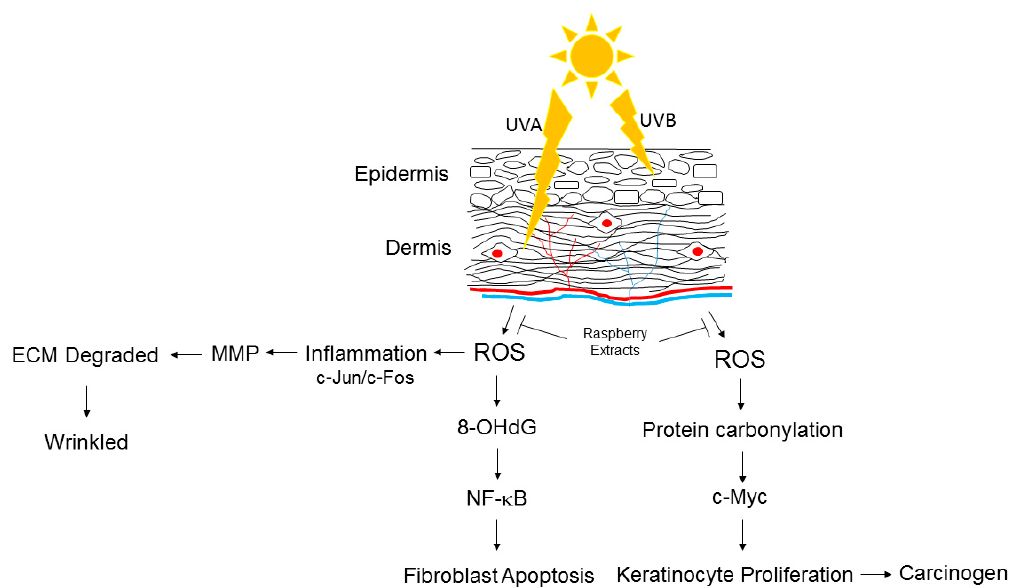
Figure 6. Proposed diagram of UVA- and UVB-mediated skin injury. Inducing oxidative modification of biological molecules such as protein and DNA lead to inflammatory responses, apoptotic cascades or carcinogenesis. ECM: extracellular matrix; ROS: reactive oxygen